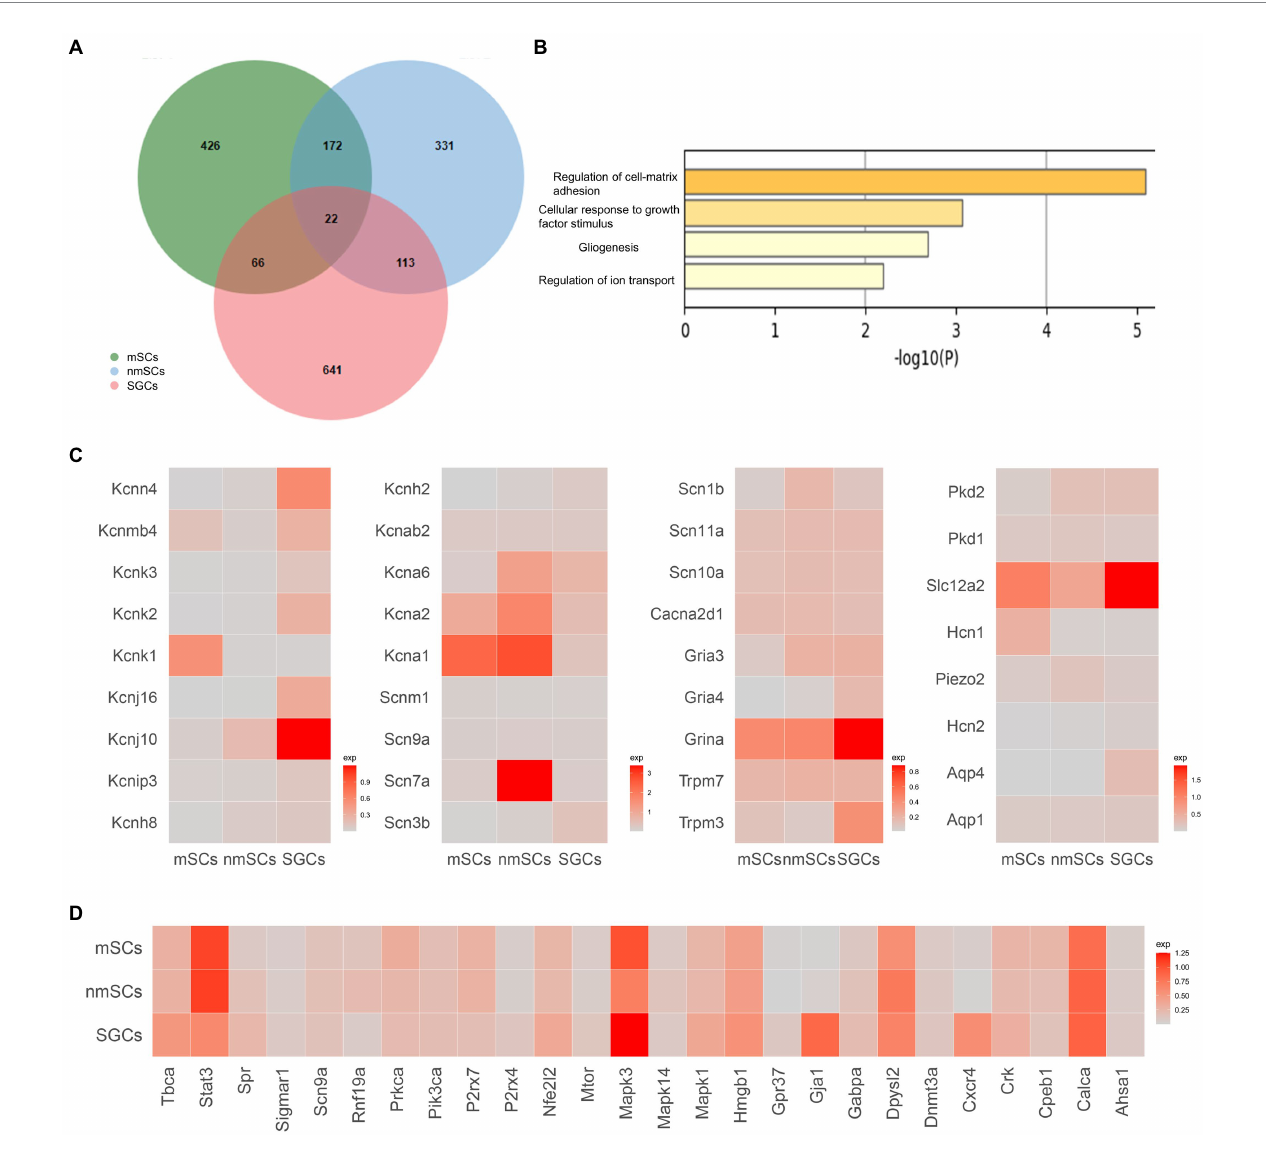
FIGURE 4 Comparison of gene expression in three types of glial cells in TG. (A) Venn diagram of the highly expressed genes of SGCs, mSCs, nmSCs. The colors denote the cell types. Number of cells for the glial cell clusters: mSCs (5647), nmSCs (1944), SGCs (3356). (B) Functional enrichment analysis of shared expression genes of SGCs, mSCs, nmSCs. The row represents-log 10 Pvalues, the column represents terms for functional enrichment. (C) Gene heat map of sodium, potassium, calcium channels, and other channels and receptors expressed in SGCs, mSCs, and nmSCs. Color intensity indicates levels of gene expression. (D) Gene heat map of pain-related gene sets expressed in SGCs, nmSCs,